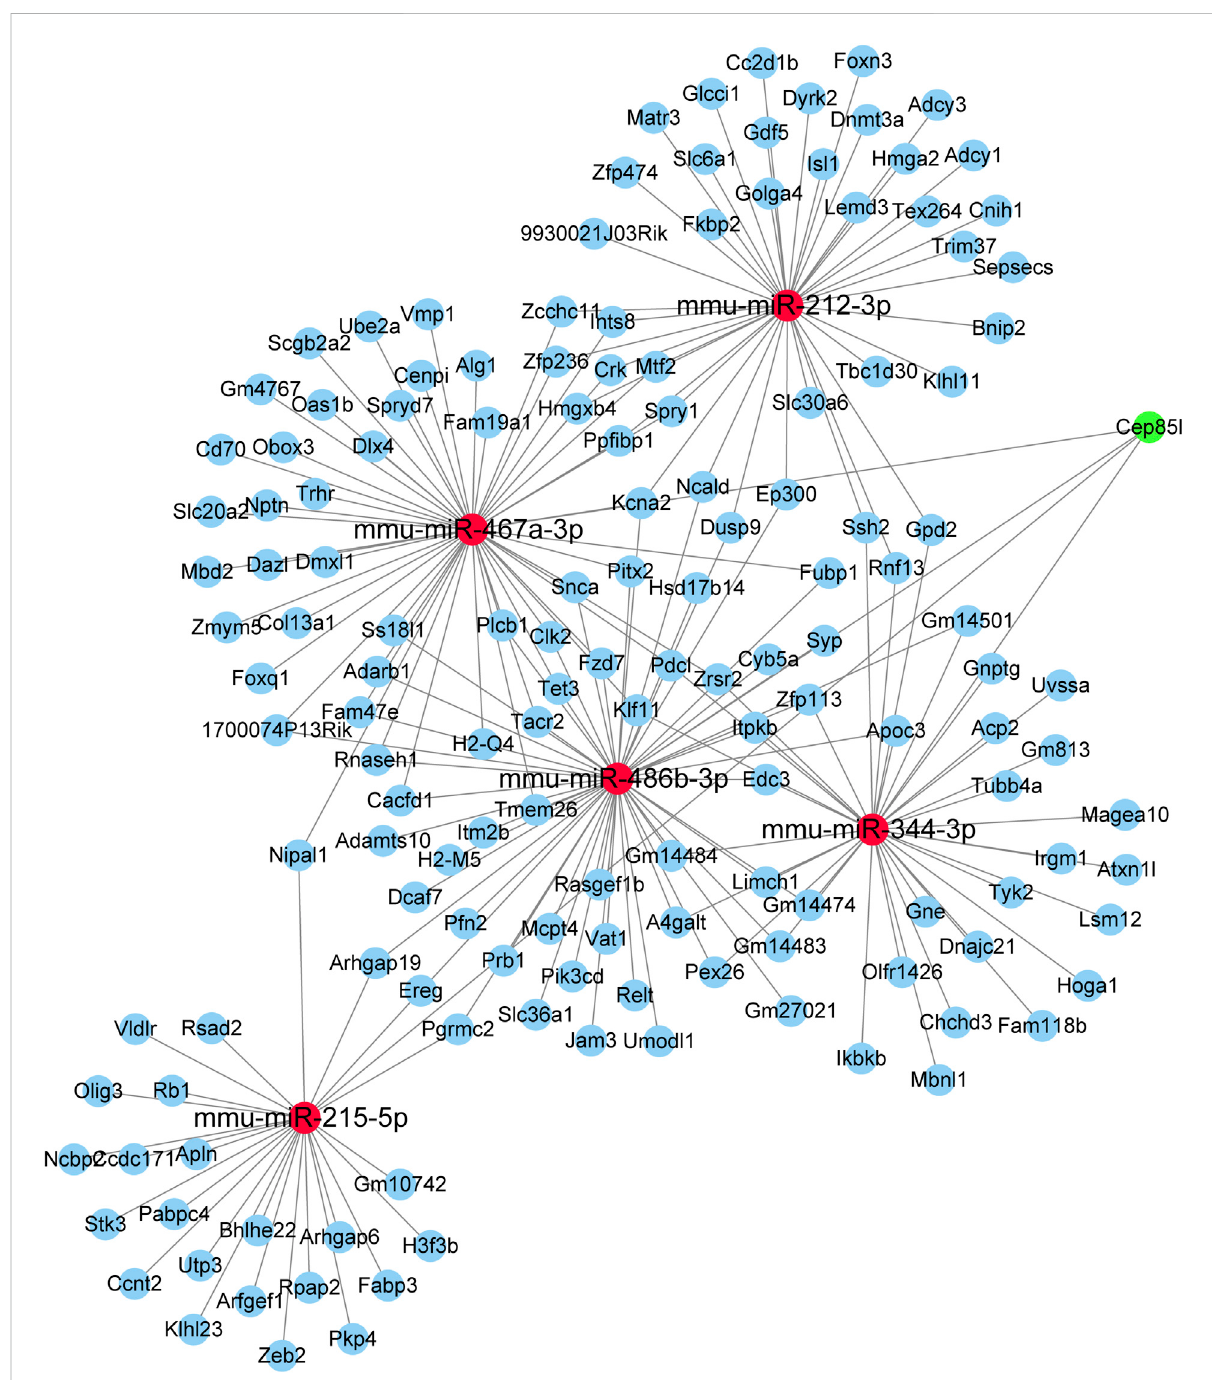
FIGURE 6 miRNA – mRNA network constructed using fi ve DEmiRs. Red nodes indicate miRNAs. Blue nodes represent